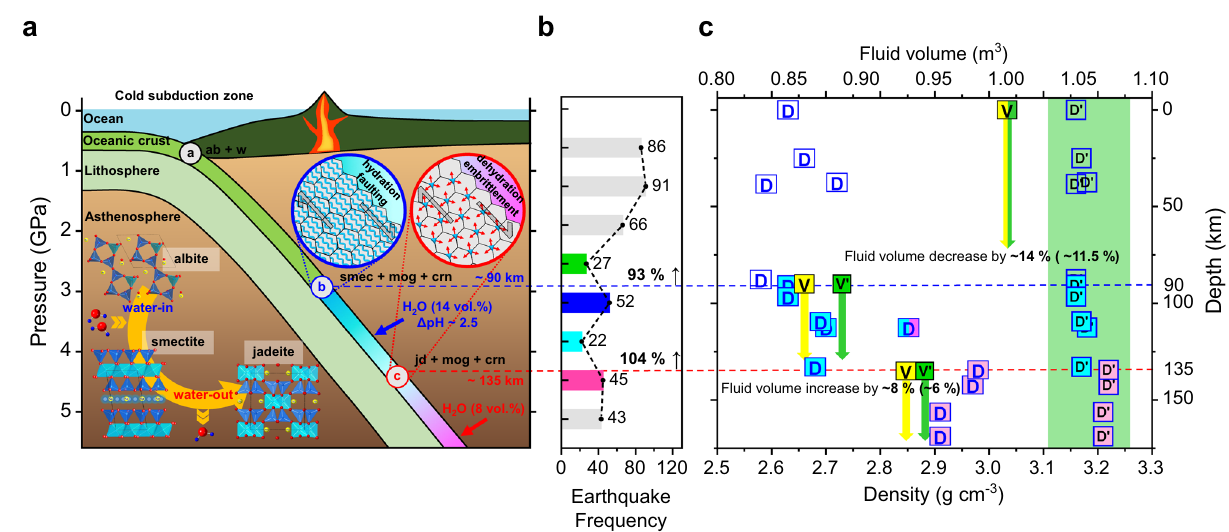
Fig. 4 The breakdown model of albite along the South Mariana trench. a The hydration and dehydration breakdowns of albite occur at ca. 90 km and 135 km depths, respectively. b The frequency of earthquake occurrence along the South Mariana trench over past 5 years (ISC Bulletin, investigation period between Nov. 2014 and Nov. 2019). c Changes in the net crystalline density ( D for albite, D ’ for basalt) and fl uid volume ( V for albite, V ’ for basalt) in the subducting system are estimated as a function of subducting depth as in a and b . Green arrow and region highlight the estimated changes based on a